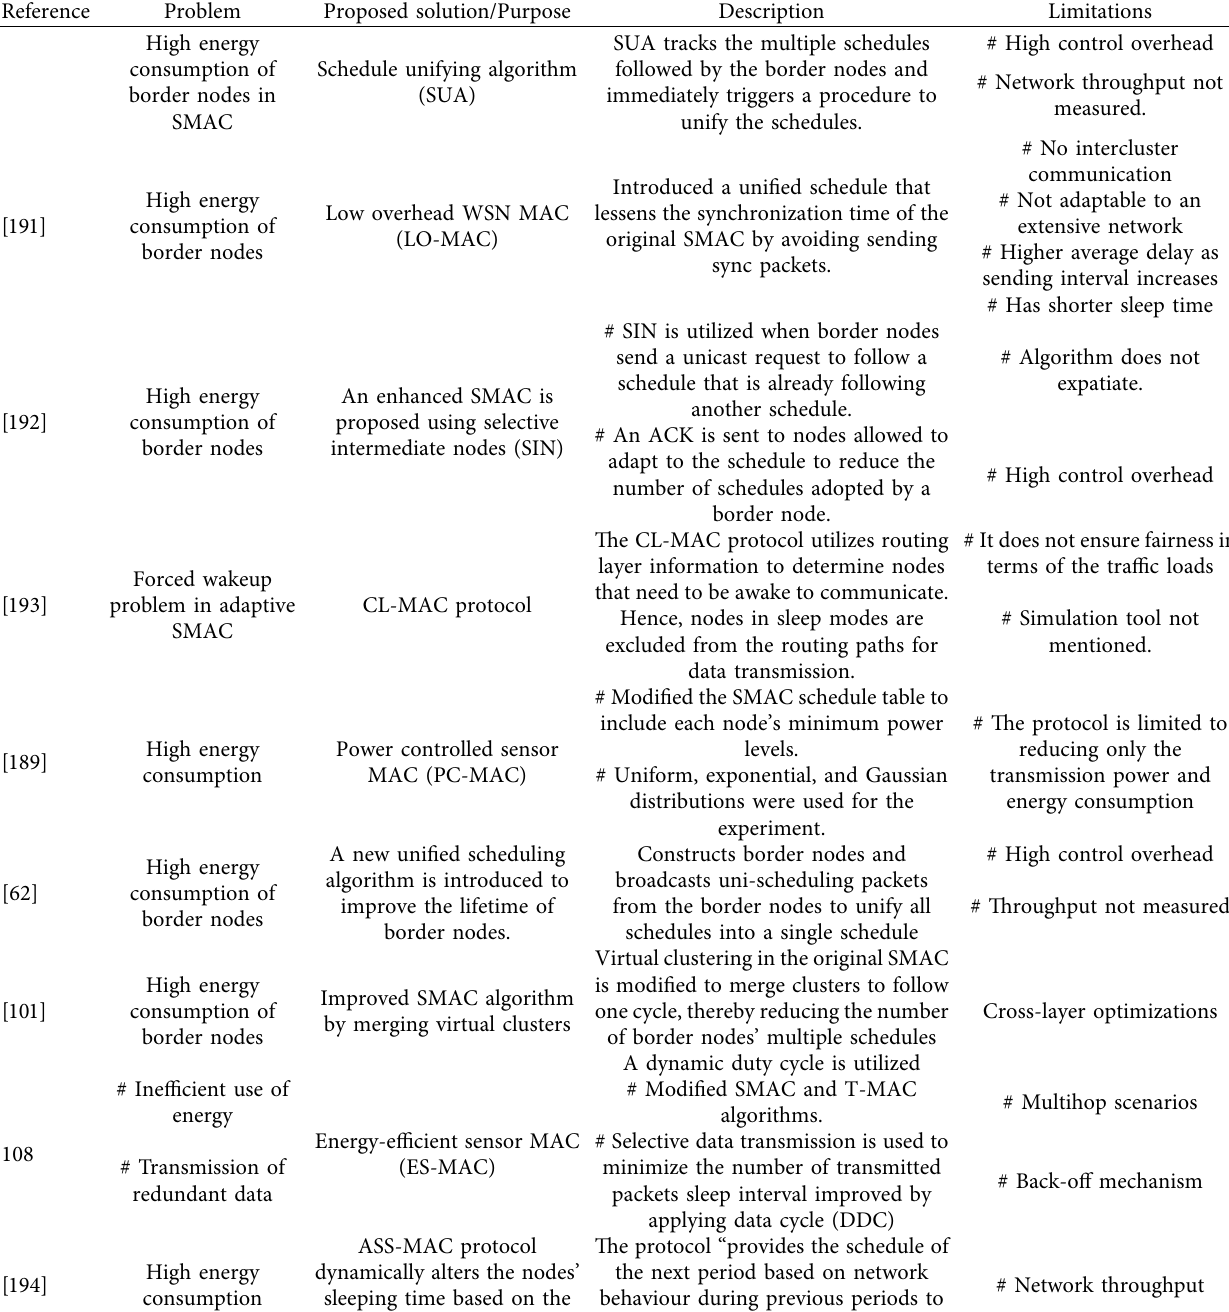
Table 5: Improved protocols for high energy consumption in SMAC